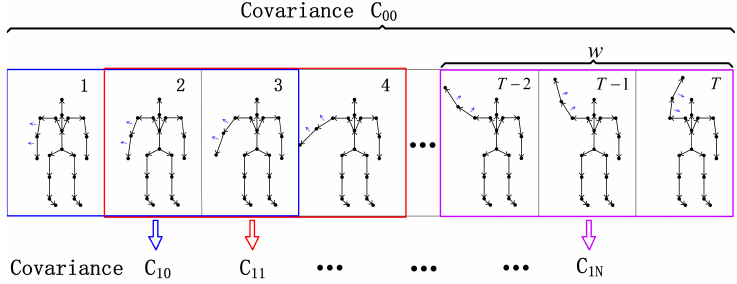
Figure 3. Temporal construction of the covariance